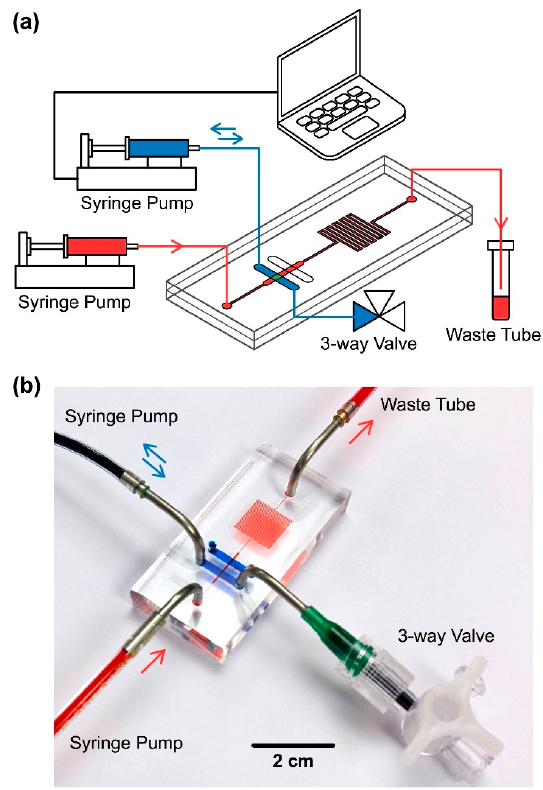
Figure 2. ( a ) Schematic and ( b ) photo of the experimental setup of the microfluidic cell culture device capable of mimicking physical stimulations within lungs. capable of mimicking physical stimulations within